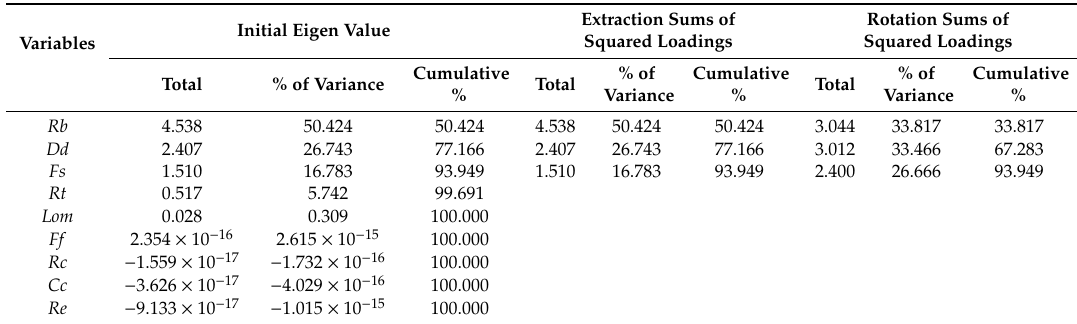
Table 7. Total variance shown for four HAL-MWs in Leimebamba and two HAL-MWs in Molinopampa (Amazonas,